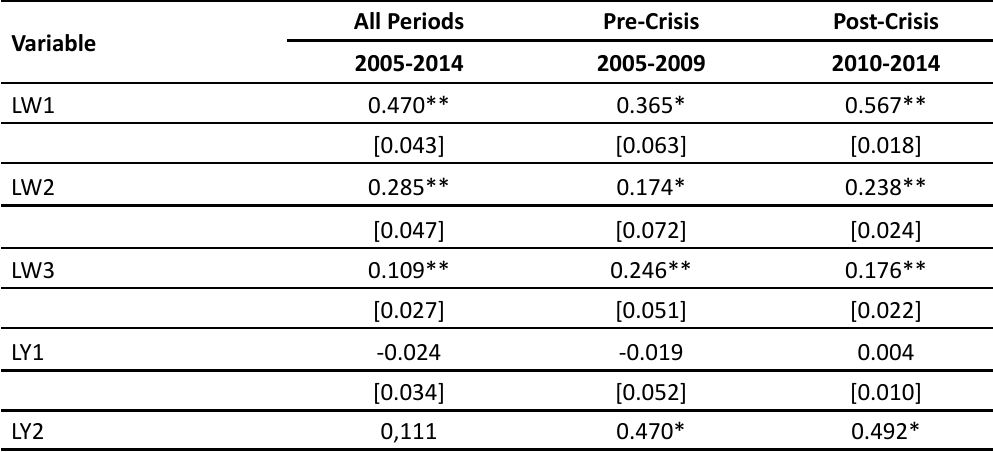
Table 5: Estimation Results for the Panzar-Rosse